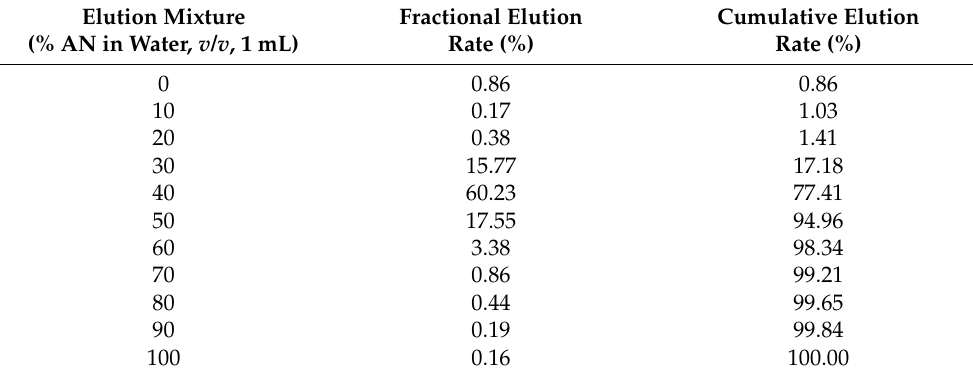
Table 1. Stepwise gradient elution of the PPG standard (10 µ g/mL in AN) from the Sep-Pak Classic C 18 SPE cartridge.